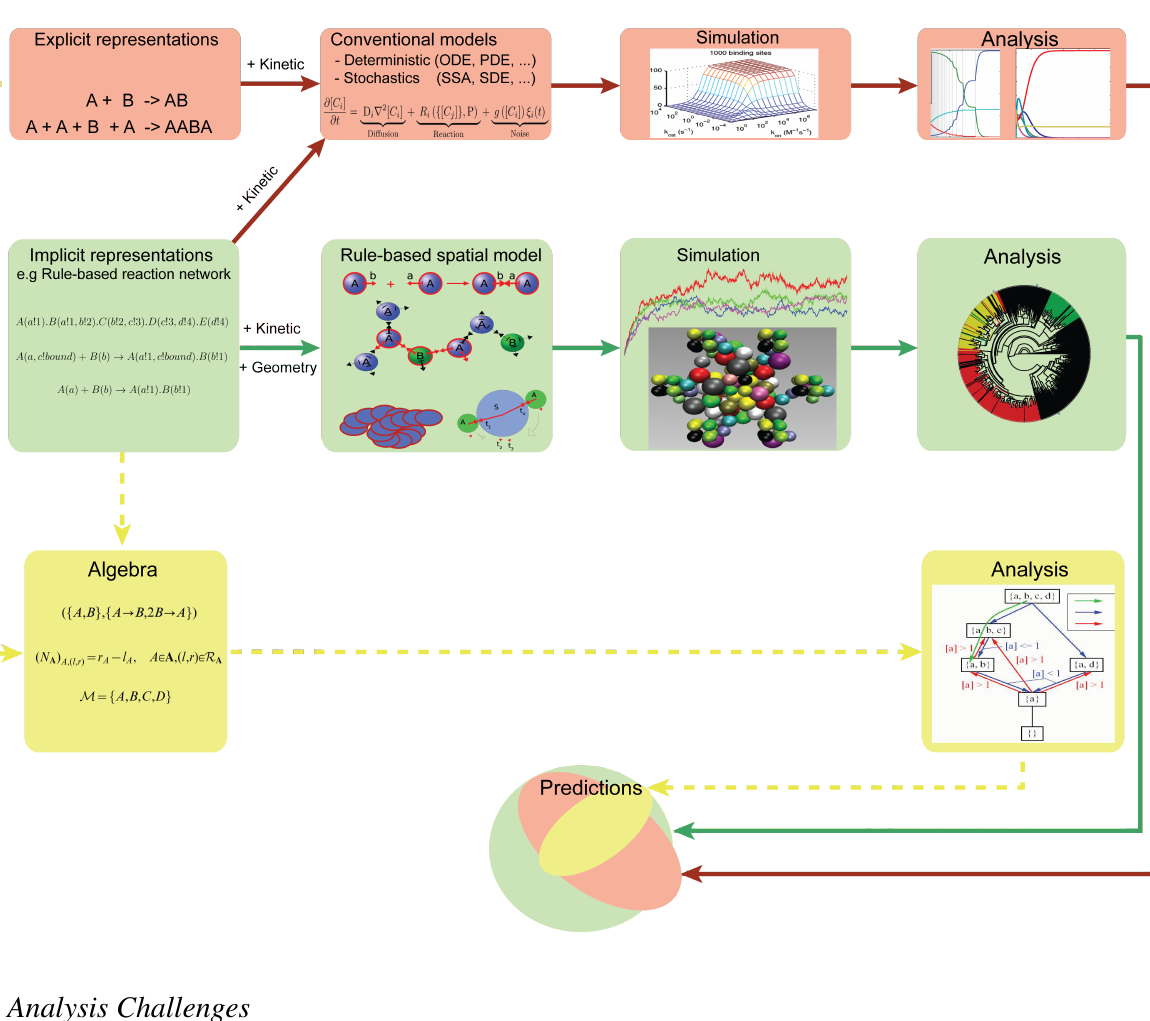
Figure 15. Illustration of modeling approaches in systems biology.